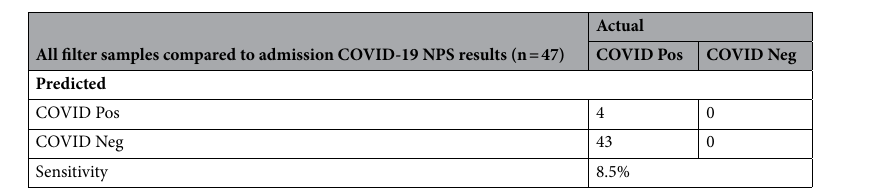
Table 3. Diagnostic performance of face mask filters compared to initial NPS for SARS-CoV-2 detection by qRT-PCR.